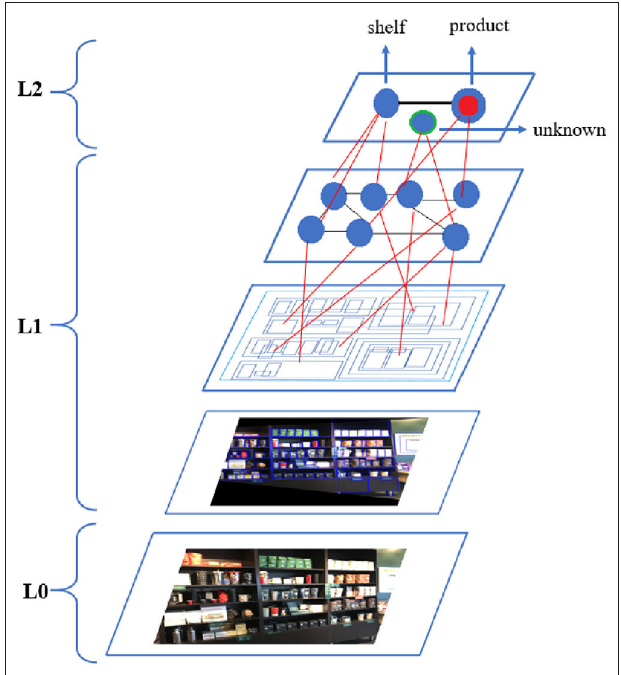
FIGURE 3 | Levels of abstraction for retail use case (from Latapie et al., 2021).